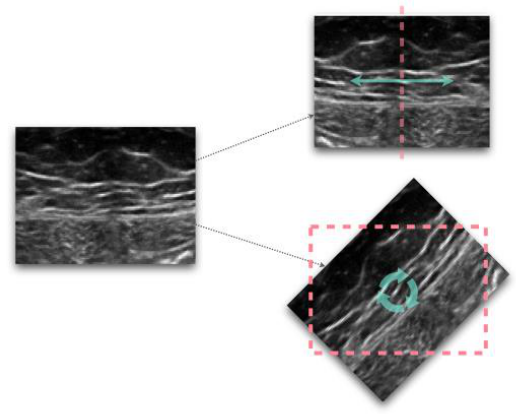
Figure 1. Examples of image transformations, flipping (top) and rotation (bottom). Table 2. Computational solutions to manage small sample